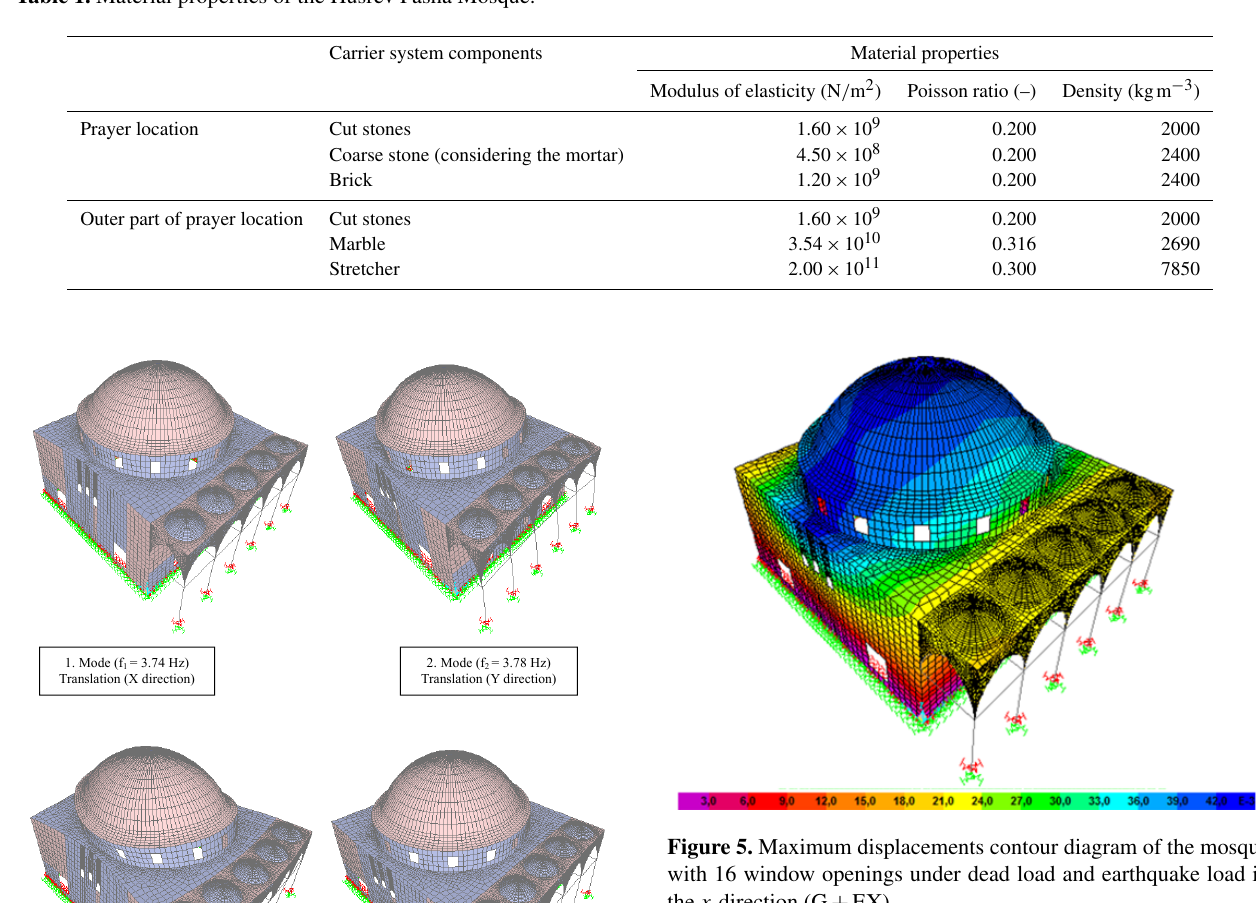
Table 1. Material properties of the Hüsrev Pasha Mosque.